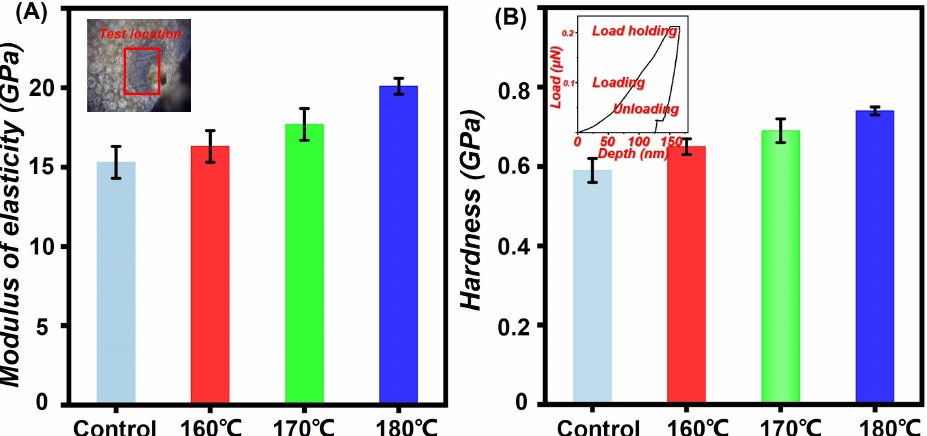
Figure 6. Micro-mechanical property characterization. ( A ) modulus of elasticity; ( B ) hardness.